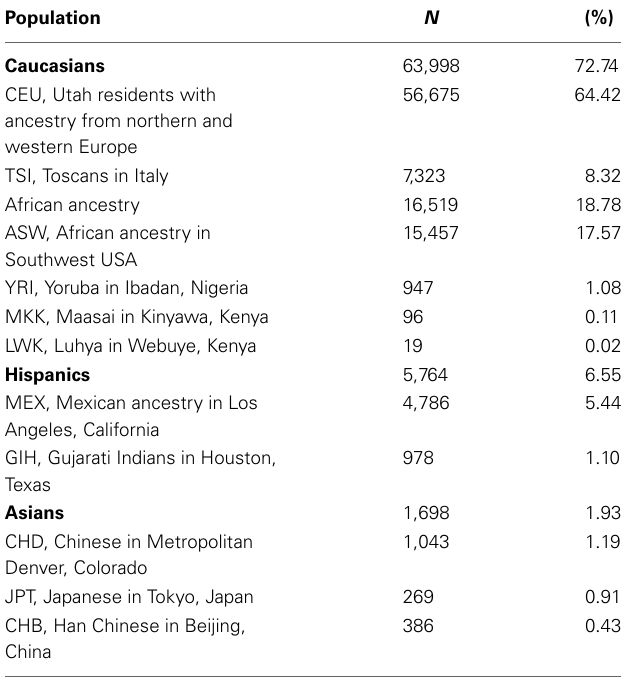
Table 1 | Frequencies of the different ethnicities in the sample investigated based on principal component analysis of imputed genotype